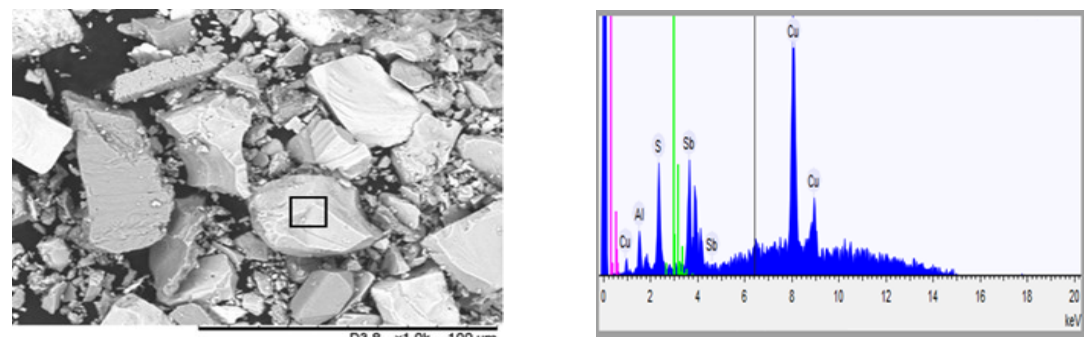
Fig. 2. SEM image and EDS spectrum analysis of polysulfide concentrate